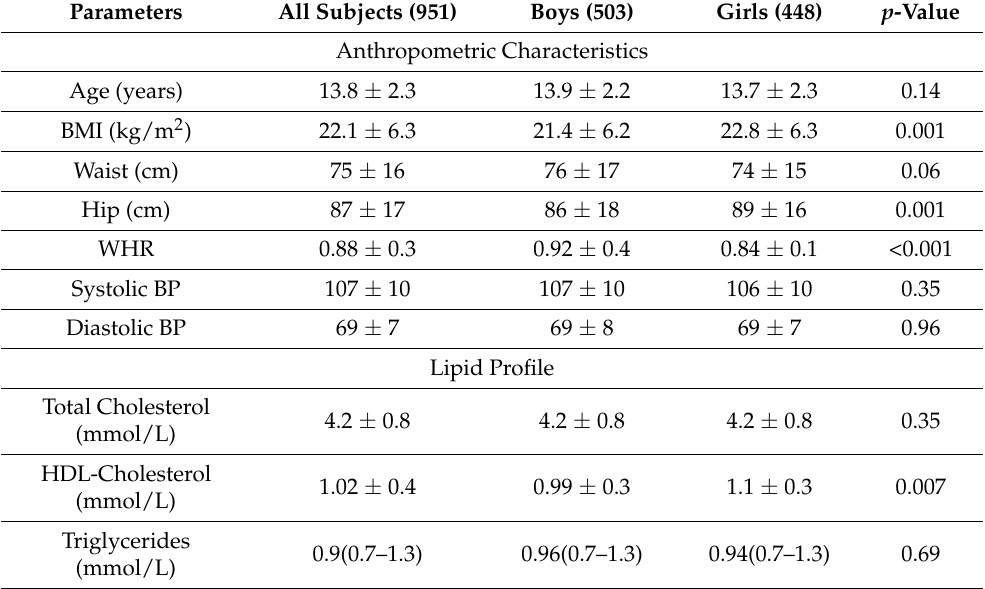
Table 1. Clinical and Anthropometric characteristics of study participants at